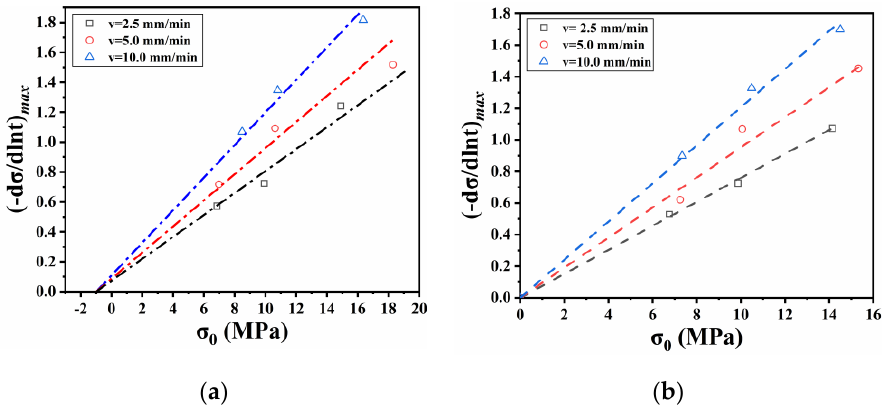
Figure 11. Relationship between (−d σ /d lnt )max and σ 0 : ( a ) longitudinal specimens; ( b ) transverse specimens.